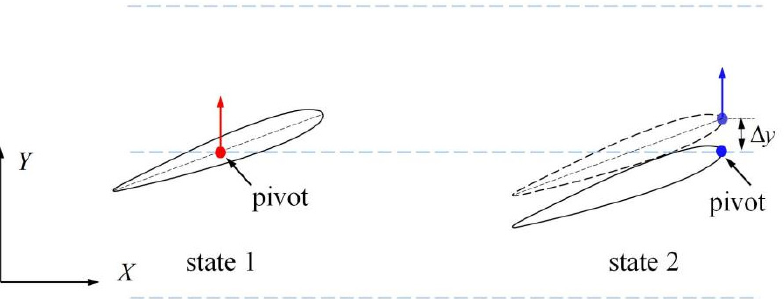
Figure 14. Geometry sketch of two same-state foils with different phase difference and pivot location. ∆ s is defined as the displacement of the pivot in the chordwise direction, and it is positive in the tailing edge direction. ∆ ϕ is defined as the change of the phase difference between the two states of the foil. Compared with state 1, state 2 is completely equivalent, but the change of phase difference ∆ ϕ = − 2 π f ∆ t , and the pivot displacement ∆ s = − c /2. The relationship between ∆ s and ∆ ϕ is derived from the geometric relationship as follows. Table 1. Definition of eight working conditions with different phase difference and pivot position.